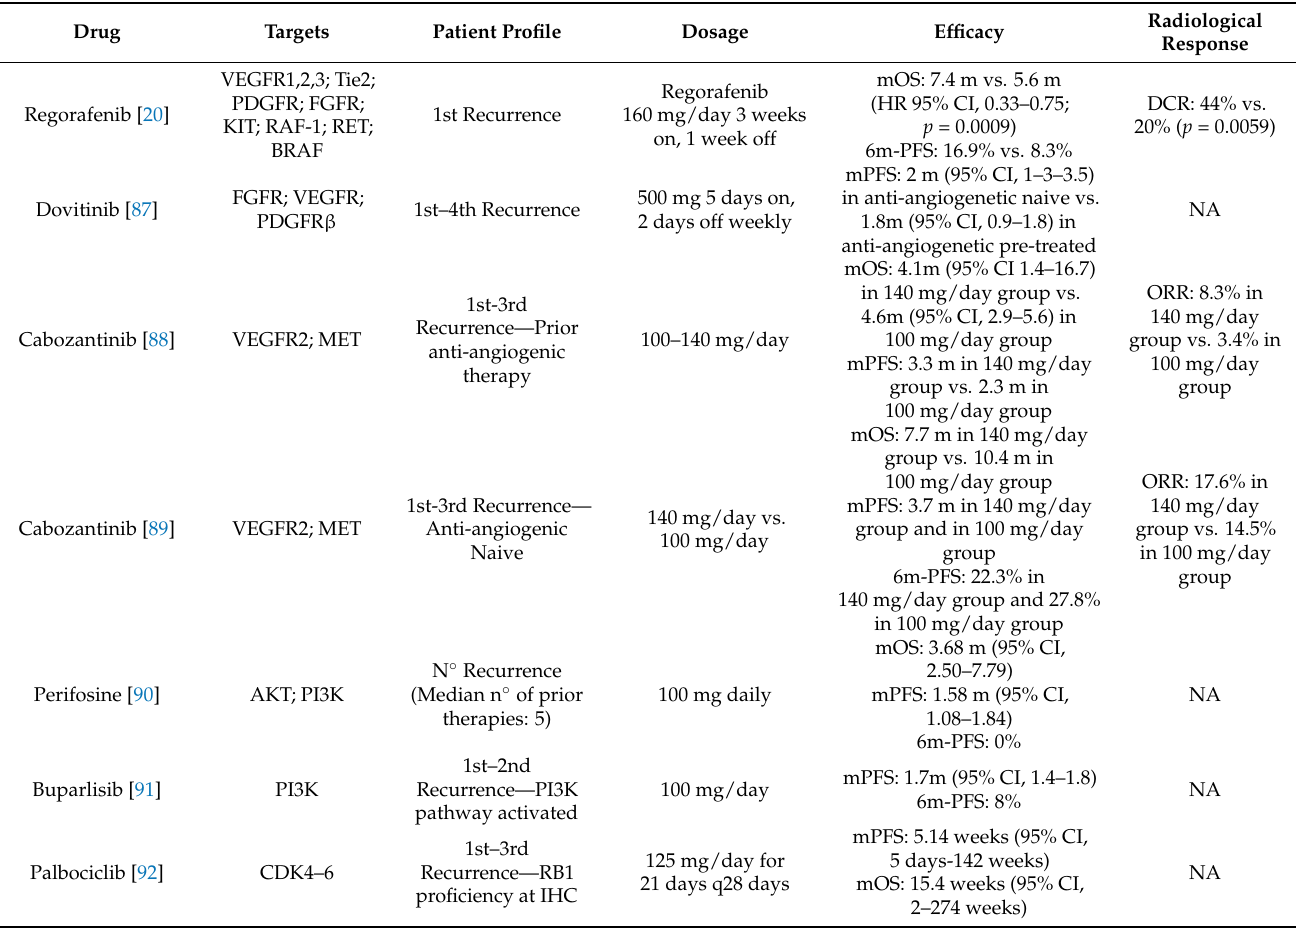
Table 3. Phase II trials analysing TKI, anti-angiogenic therapy and combination treatments. Drug Targets Patient Profile Dosage Efficacy